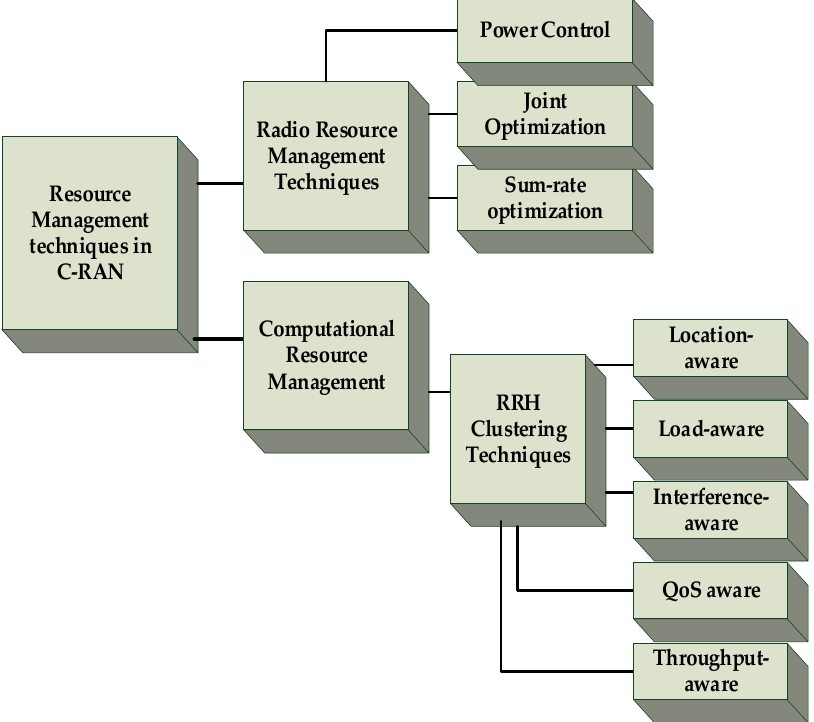
Figure 4. Resource management techniques in C ‐ RAN.